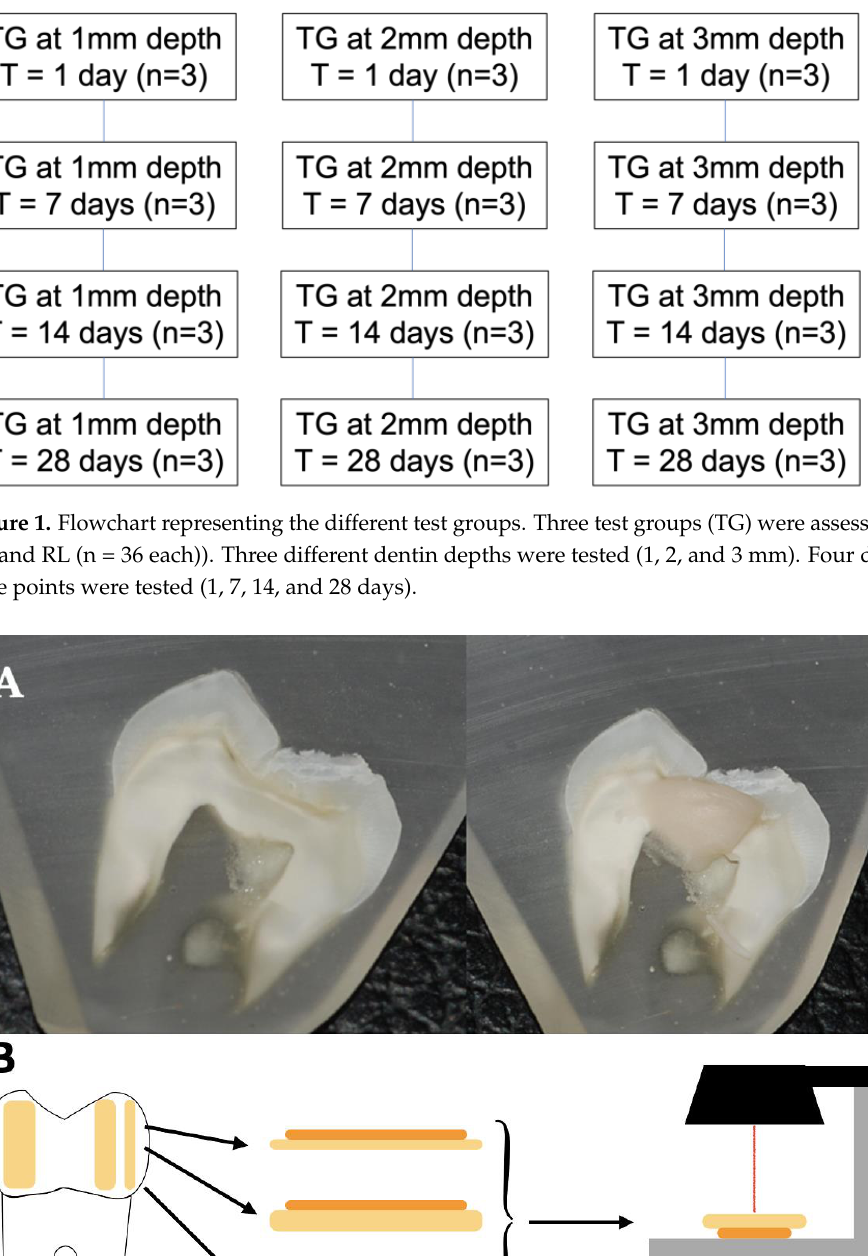
Figure 1. Flowchart representing the different test groups. Three test groups (TG) were assessed (KM, EF, and RL (n = 36 each)). Three different dentin depths were tested (1, 2, and 3 mm). Four different time points were tested (1, 7, 14, and 28 days).